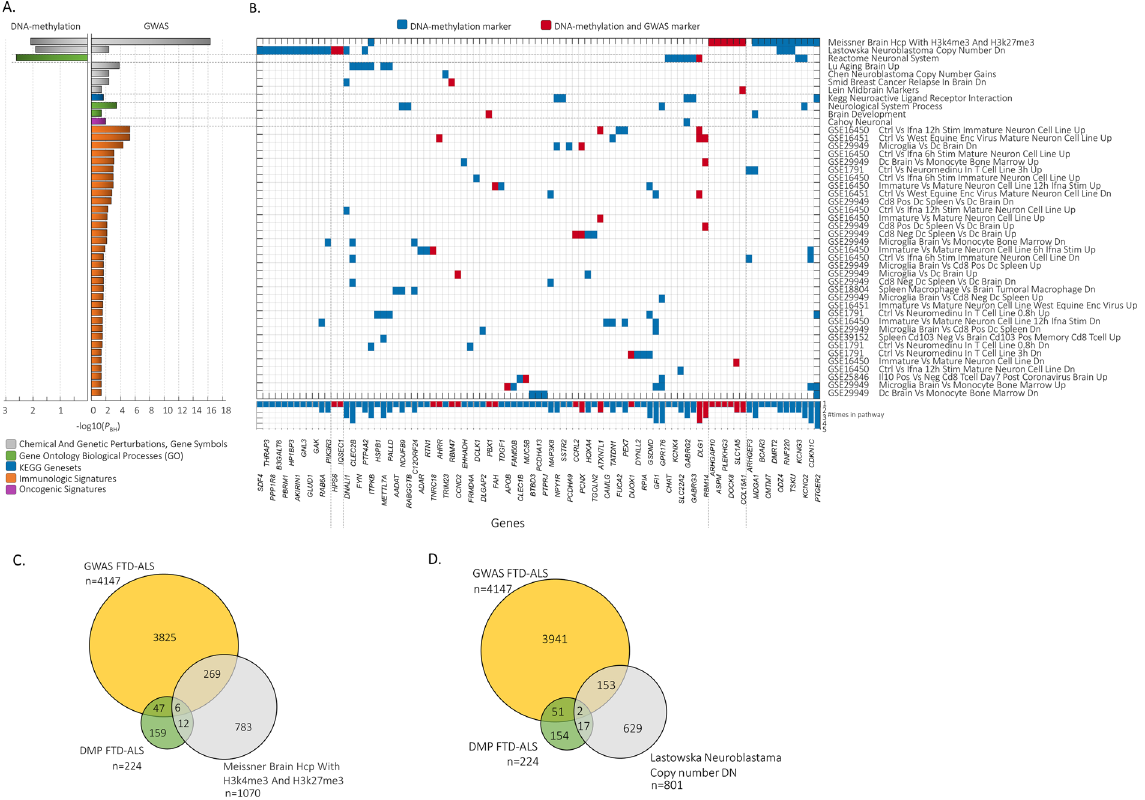
Figure 3. Enriched pathways for FTD-ALS. ( A ) Significantly enriched pathways using the DMP and GWAS associated genes of FTD-ALS. ( B ) Blue colored squares depict overlap of genes between FTD-ALS markers and pathway associated genes, whereas a red colored square also depicts overlap with the GWAS associated genes. ( C ) Venn diagram depicts the overlap between FTD-ALS genes from DMP (n = 224), GWAS (n = 4147), and the genes in gene set Meissner Brain Hcp with H3k4me3 and H3k27me3 (n = 1070), and ( D ) Lastowska Neuroblastama Copy number DN (n =